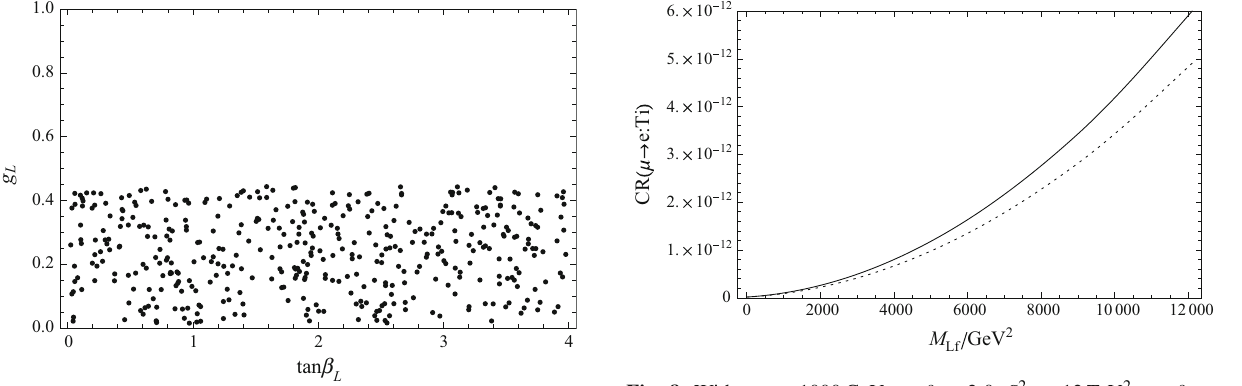
= 10 4 GeV 2 , we plot Lf